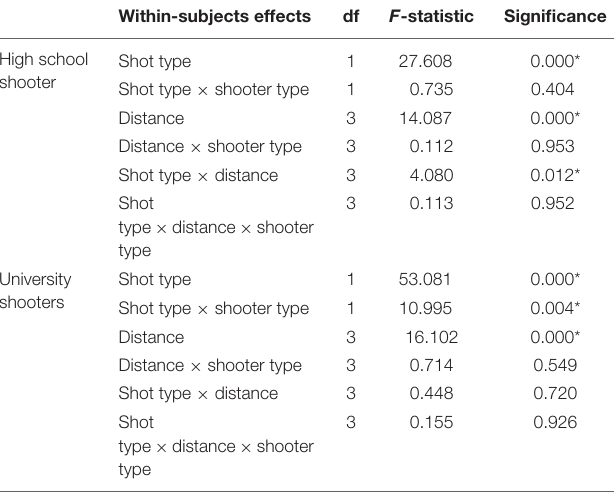
TABLE 3 | Summary of means in shooting data. TABLE 4 | Main effects and interactions of the present